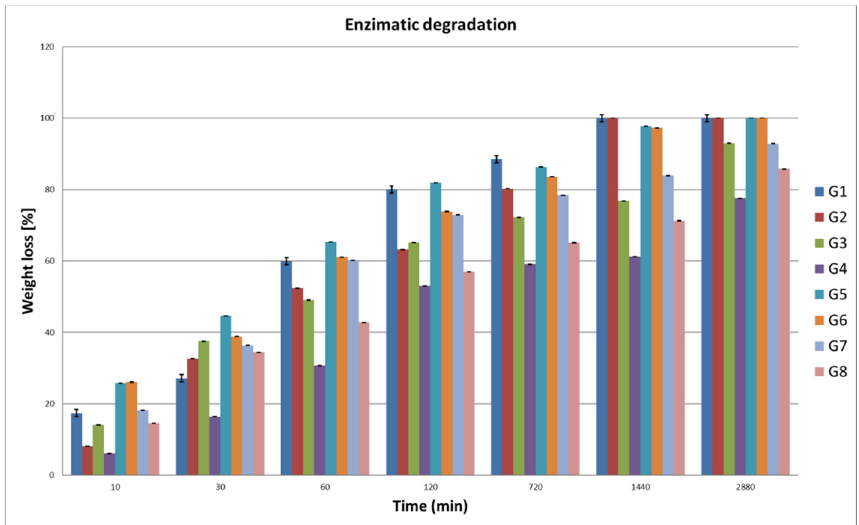
Figure 4. Enzymatic stability of the designed microcapsules; each value represents the mean ± SD for three determinations.